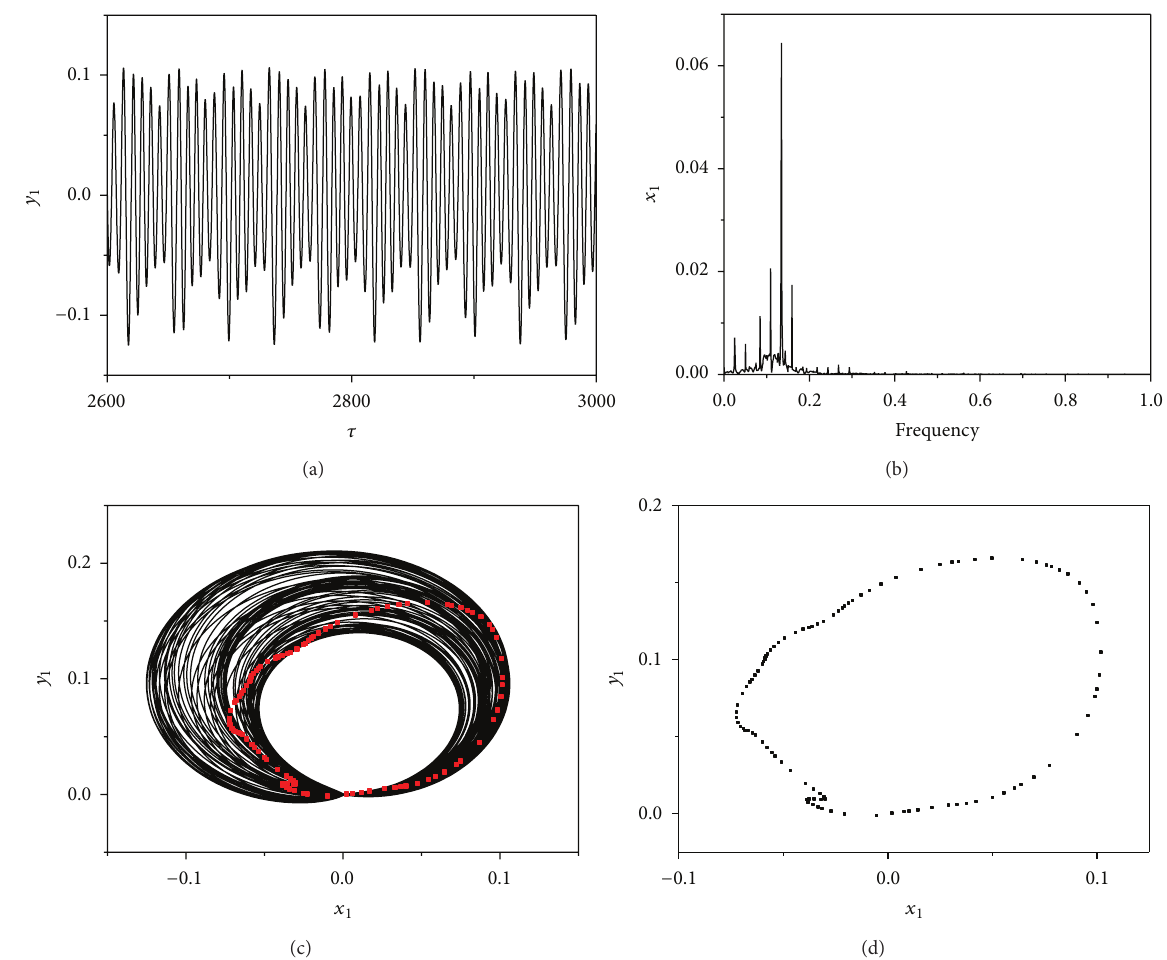
Figure 9: See 𝜔 = 1.20 . (a) Displacement response. (b) Frequency spectrum. (c) Rotor orbit. (d) Poincar´e